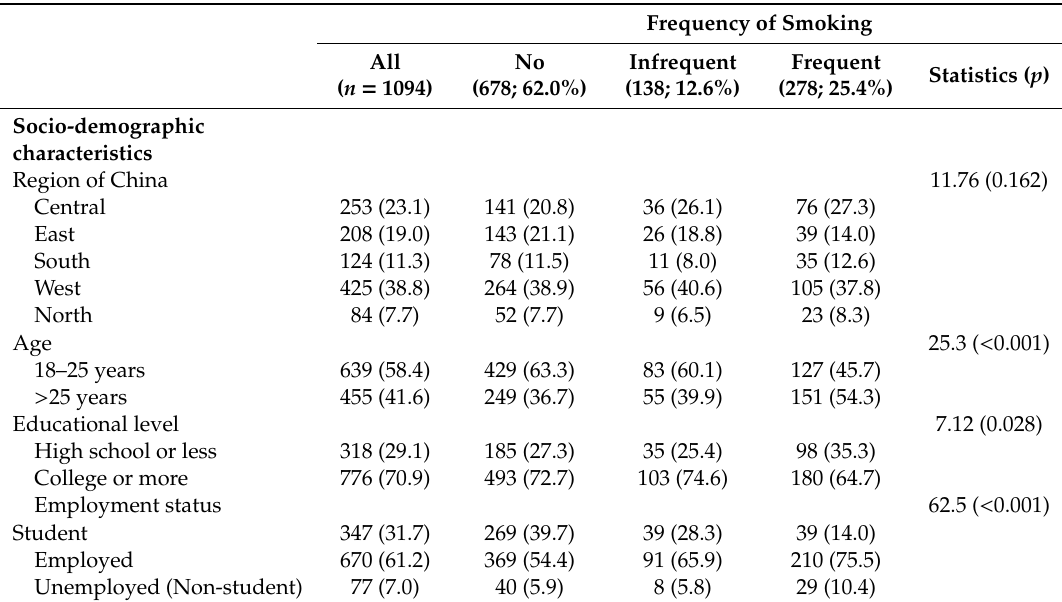
Table 2. Participant socio-demographic characteristics and sexual identity by frequency of current smoking among a national sample of Chinese